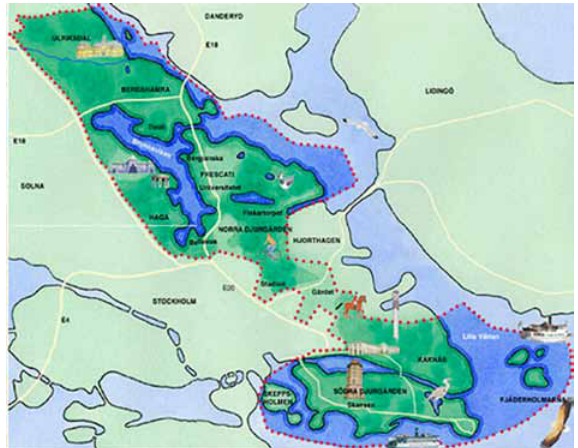
fig. 1. Greenbelt of the Stockholm national City Park, with its wide range of significant natural, cultural and recreational values (reproduced by ann nyström for association of Eco- park, förbundet för